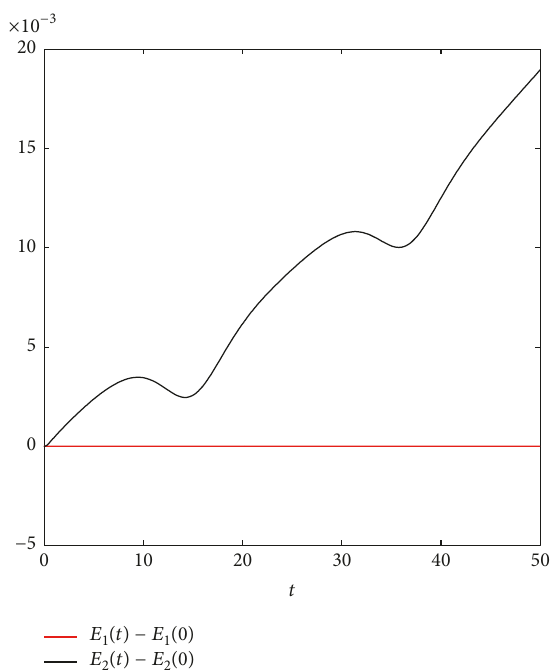
3 2 (𝑘 3𝑑 (𝑥−𝑥 )) 2 , 𝑗 sech 𝑗 𝑗 𝑗=1